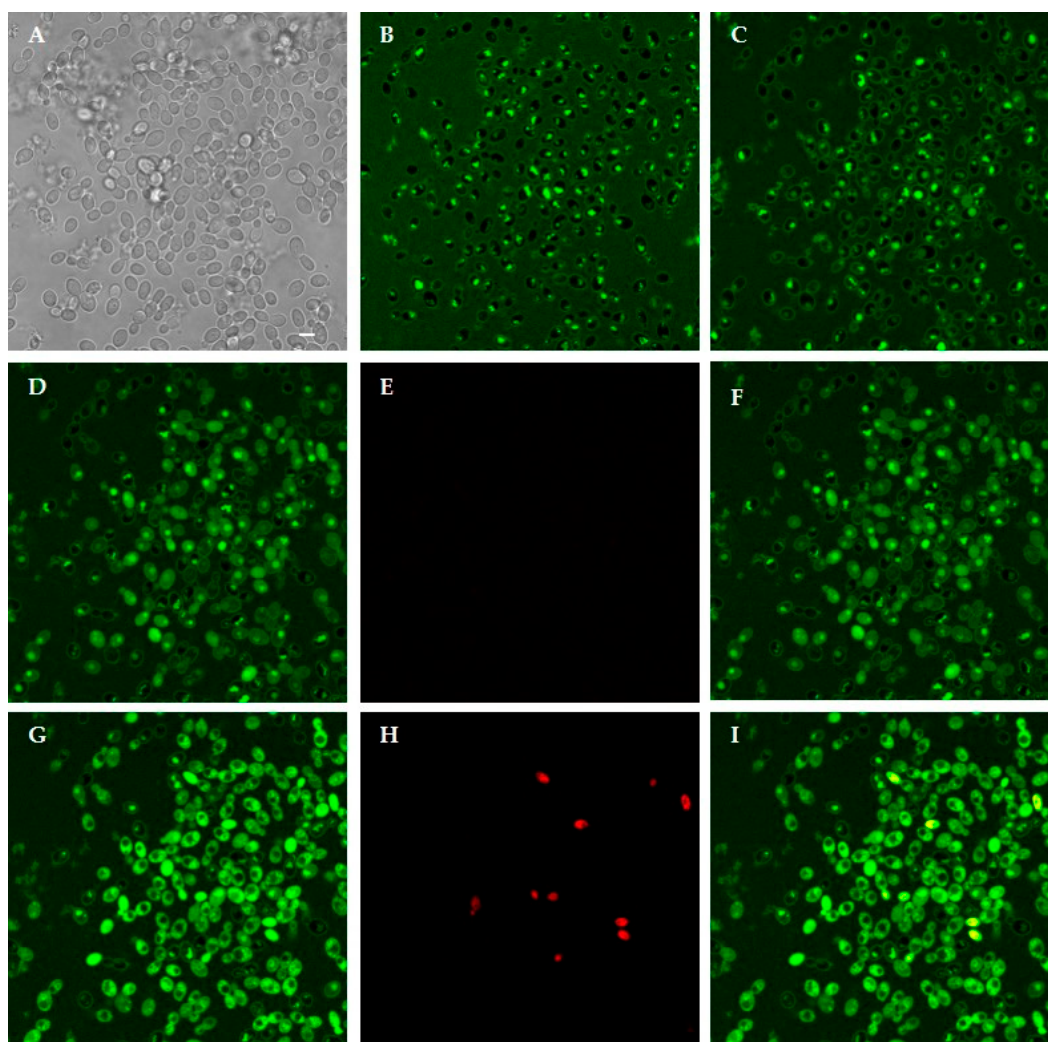
Figure 9. Interaction between living Candida albicans cells and FITC-labeled H10S. Confocal microscopy images of yeast cells incubated for 10 min and 180 min with the labeled peptide are shown in ( B , C ), respectively. H10S was internalized in most yeast cells. In ( A ), the same field is shown in light transmission. Peptide internalization increased in viable cells after 240 min: ( D ) FITC; ( E ) PI; ( F ) merge of ( D , E ), eventually leading to cell death, as demonstrated by PI internalization at 360 min: ( G ) FITC; ( H ) PI; ( I ) merge of ( G , H ). Bar, 5 µm.